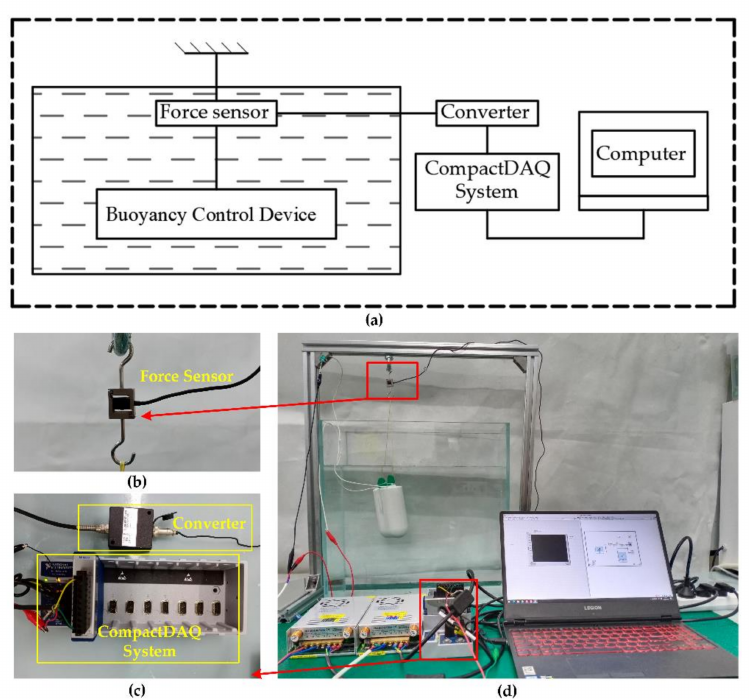
Figure 7. Buoyancy adjustment ability test bench: ( a ) schematic diagram of buoyancy testing system; ( b ) tension sensor (range 0–4.9 N); ( c ) CompactDAQ system; ( d ) buoyancy adjustment performance test